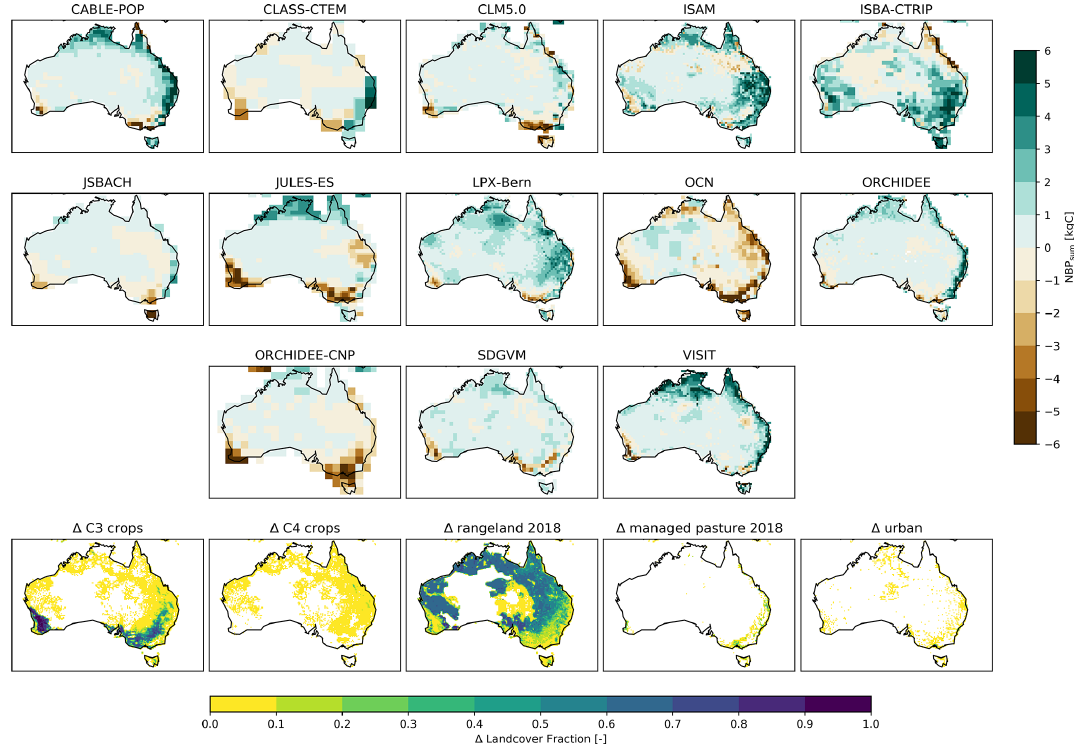
Figure C6. Cumulative NBP for all TRENDY models over 1901–2018. Land-use change based on Hurtt et al. (2020): increase in C 3 and C 4 crops, rangeland, managed pasture, and urban areas in 2018 compared to 1901.